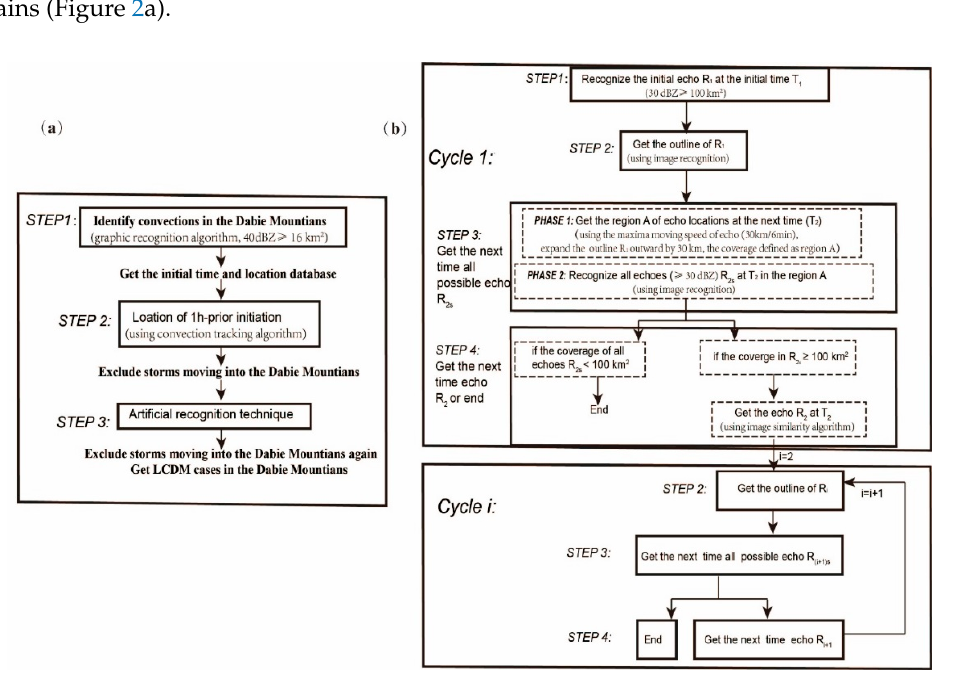
Table 1. The number of local convections in Dabie Mountains during 2014–2018 in the warm seasons (from April to September).